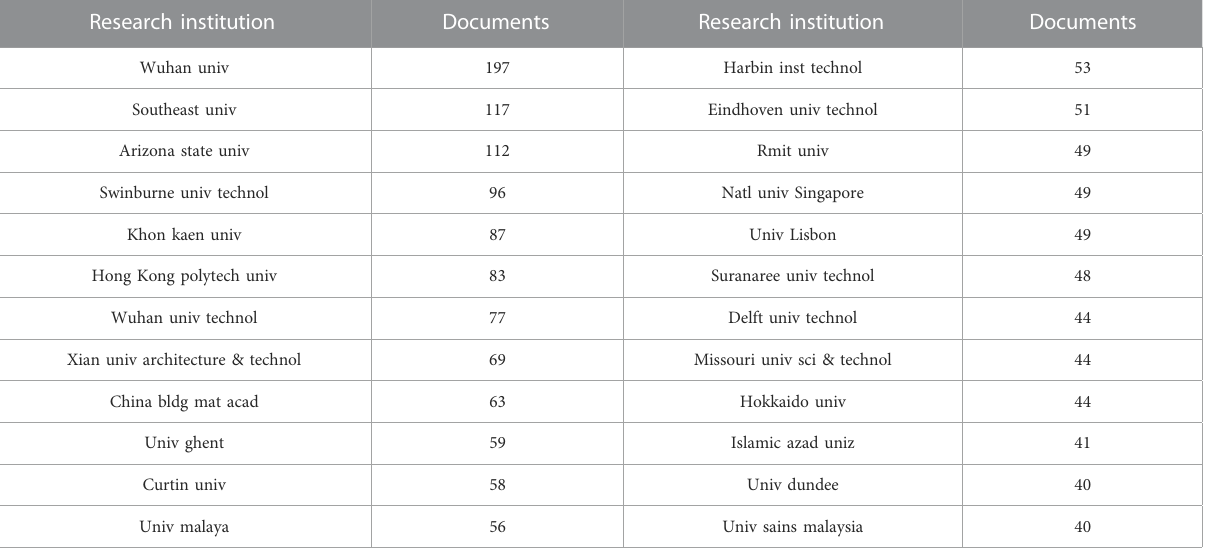
TABLE 5 Distribution of ecological concrete research institutions from